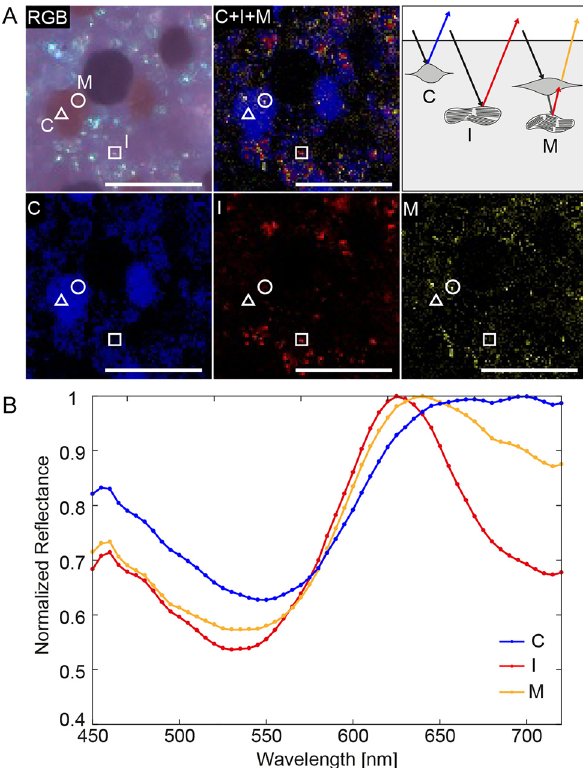
Figure 4: Multispectral analysis of color modulation in excised octopus ’